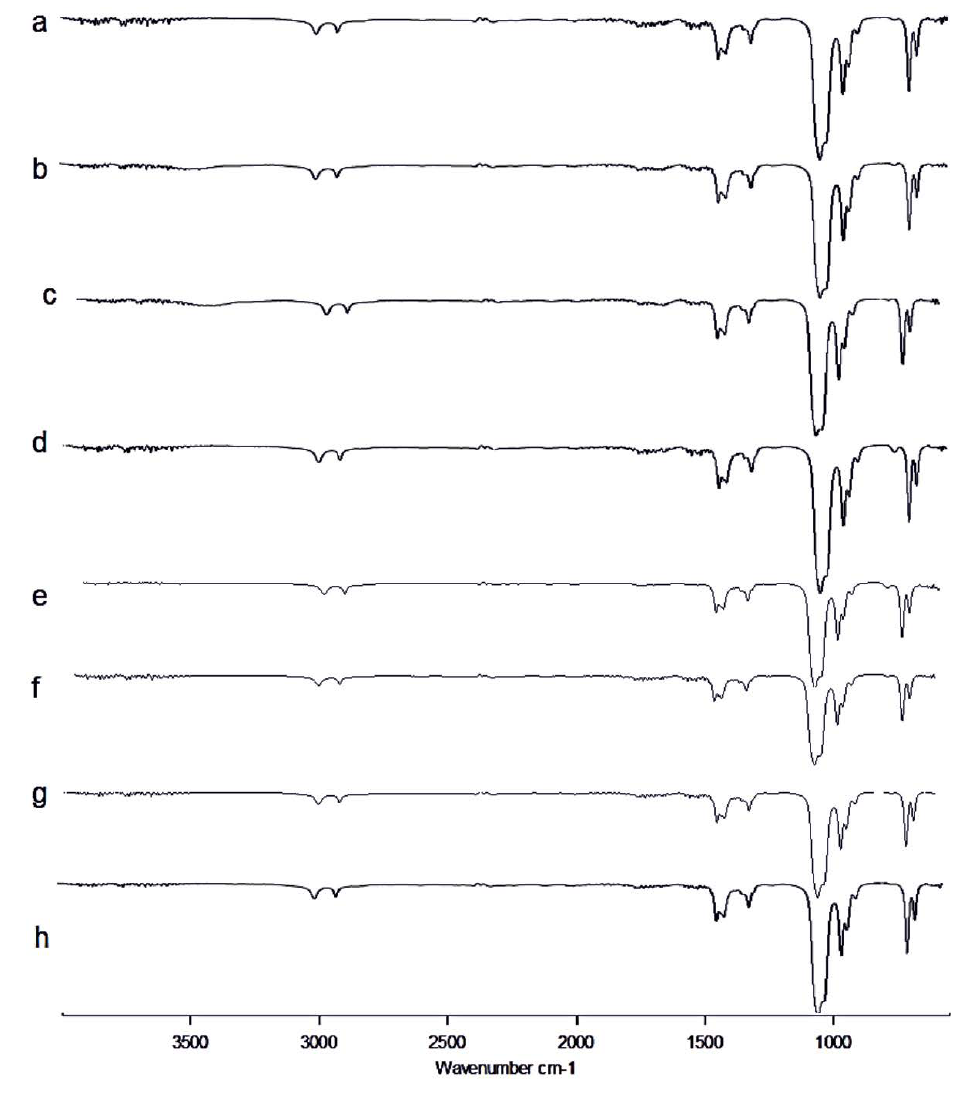
Fig. 6. FT-IR of Rhamnolipid extracted (a) Control, (b) Punica granatum, (c) Citrus reticulata, (d) Vitis amurensis, (e) Carica papaya, (f) Vitis vinifera, (g) Ananas comosus, (h) Ficus